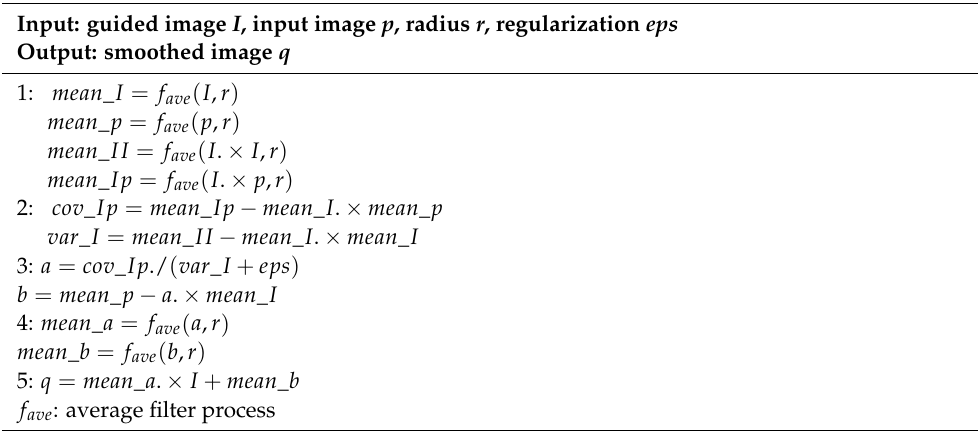
Algorithm 1: Algorithm of guided